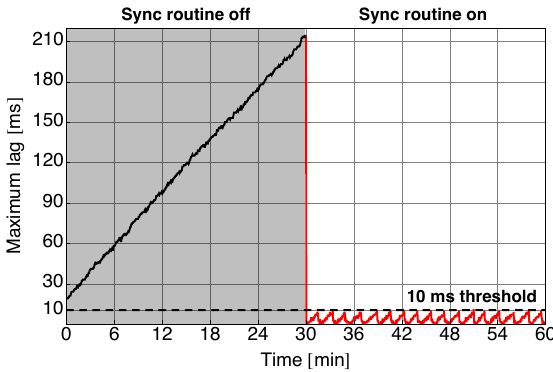
Figure 8. Evolution of the maximum lag over time and results of the sync